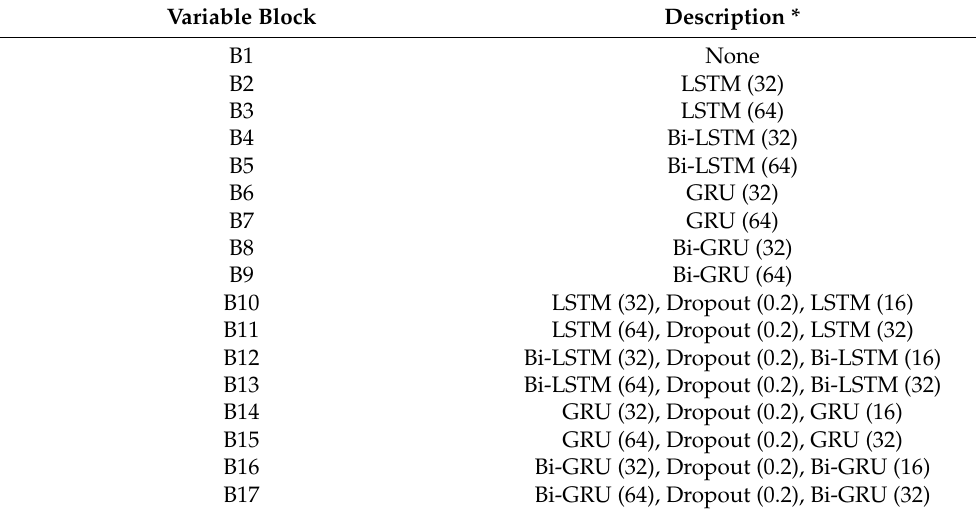
Table 5. Tested method and Description.